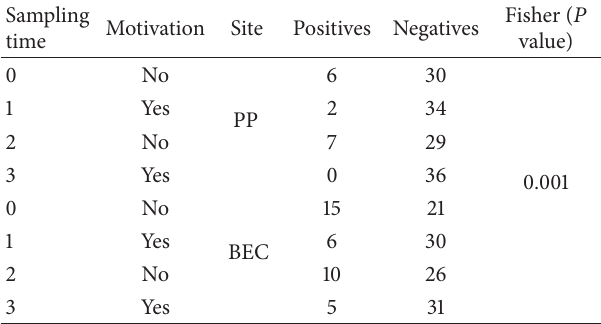
Table 2: Distribution of positivity by site and sampling time.